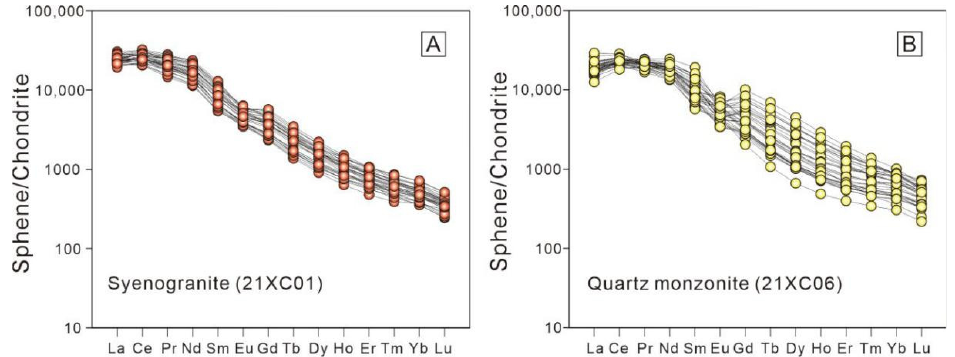
Figure 8. Chondrite ‐ normalized REE patterns plots: ( A ) for sphene in syenogranite (21XC01); ( B ) for sphene in quartz monzonite (21XC06).